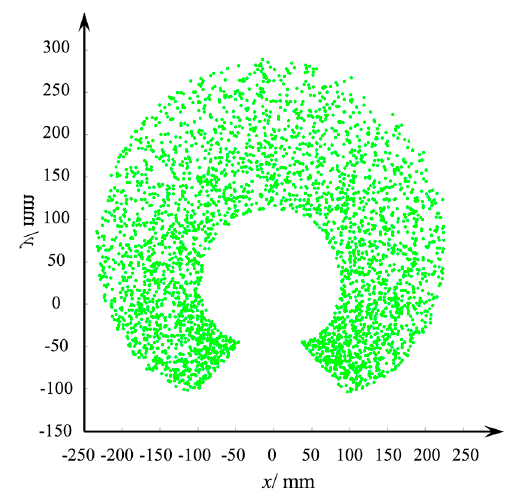
Figure 5. Workspace of the space continuous robot.